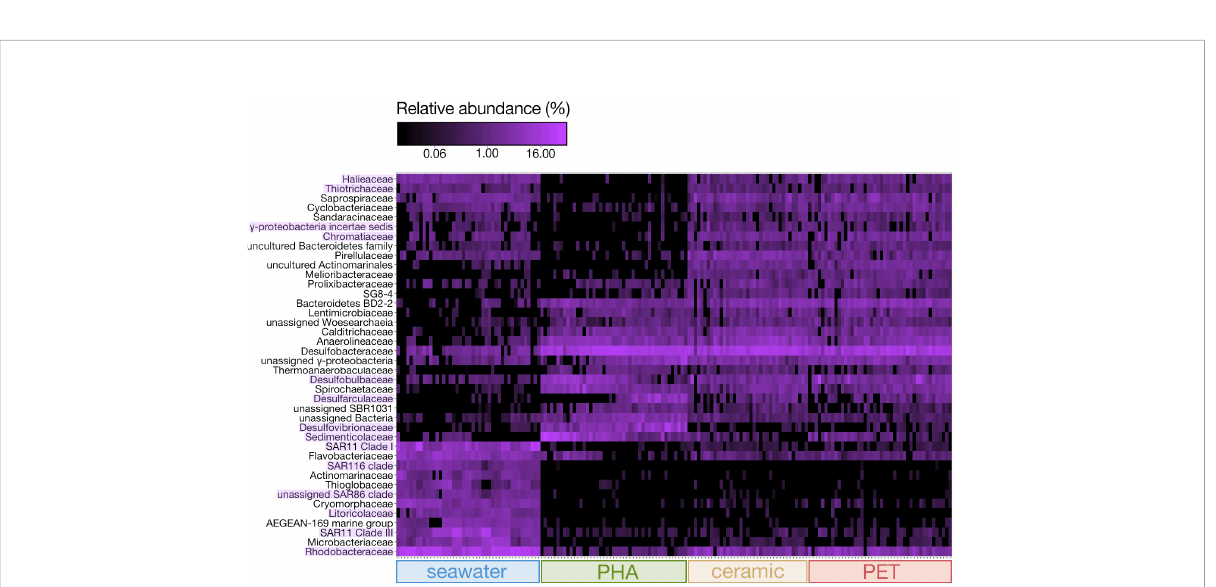
FIGURE 4 Heatmap based on the relative abundances of the 50 most abundant families across the three substrate types (ceramic, PET, PHA) and seawater and across all timepoints (0 – 424 days exposure). Families of interest with differential abundance between substrates are highlighted in